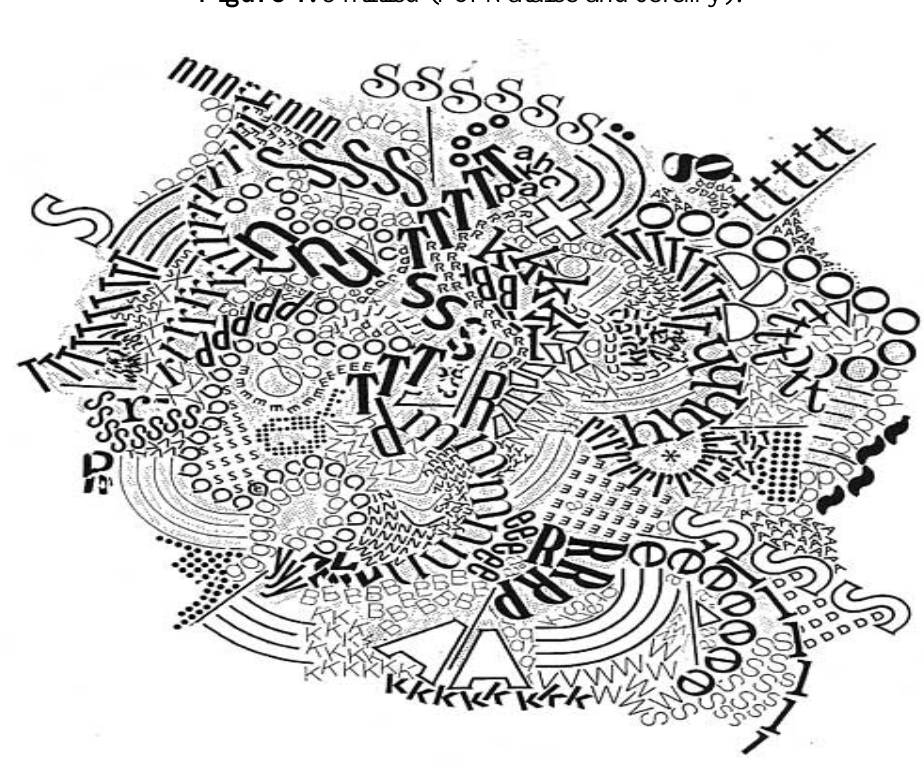
Figure 4. Untitled (For Natalee and